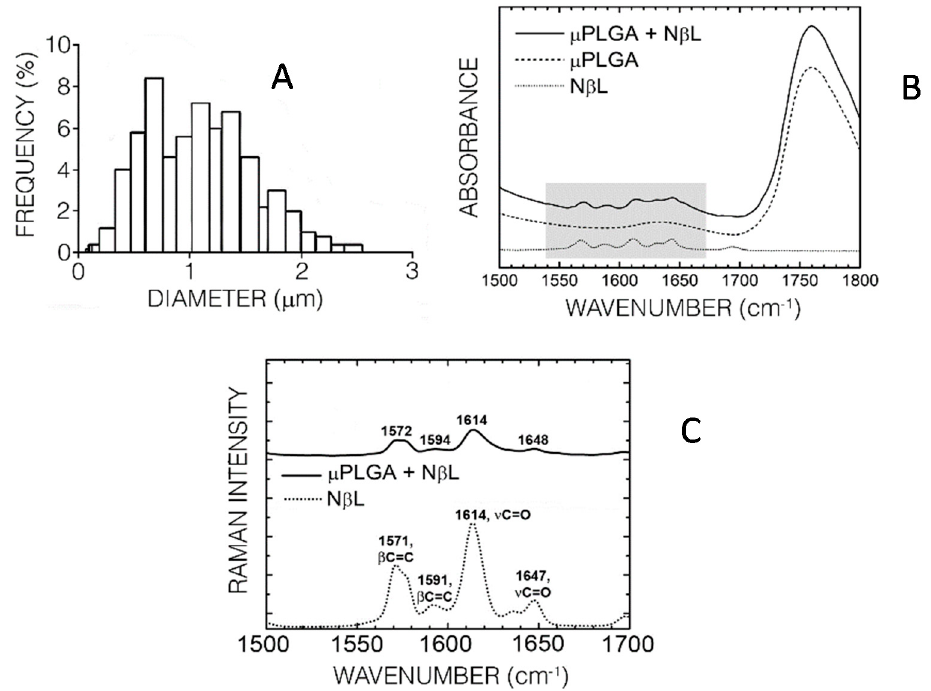
Figure 2. Characterization of the N β L-loaded PLGA microcapsules. ( A ) Size distribution of 500 microcapsules; ( B , C ) Respectively, infrared and Raman spectra of pure N β L (dotted line), empty PLGA microcapsules (dashed line) and N β L-loaded PLGA microcapsules (black line). The shading in the IR absorption spectrum highlights the wavenumber region depicted in the Raman plot. Raman band wavenumbers and their corresponding normal mode assignments are depicted as well.